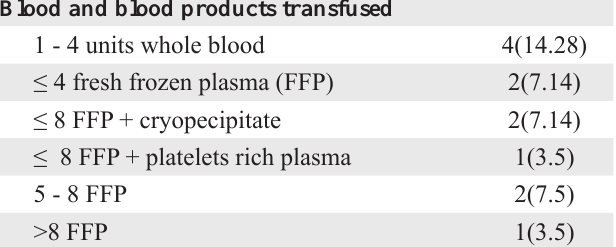
Blood and blood products transfused